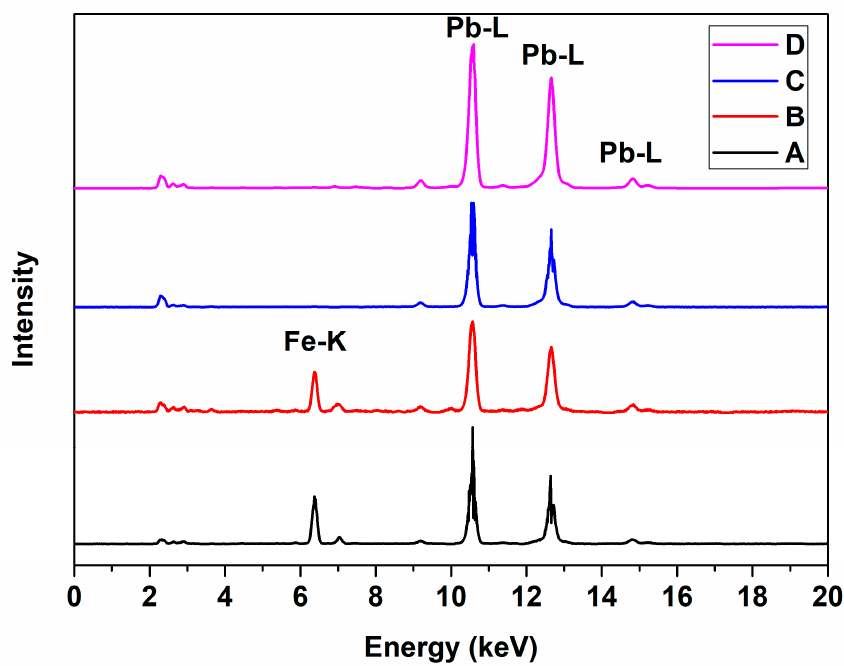
Figure 9. First base obtained in the analysis by NMF of the MA-XRF data of the paintings. Firmino Monteiro ( A ); Henrique Bernadelli ( B ); “ Gioventú ” from Eliseu Visconti ( C ); “ A poesia e o amor afastando a virtude do vício ” from Eliseu Visconti ( D